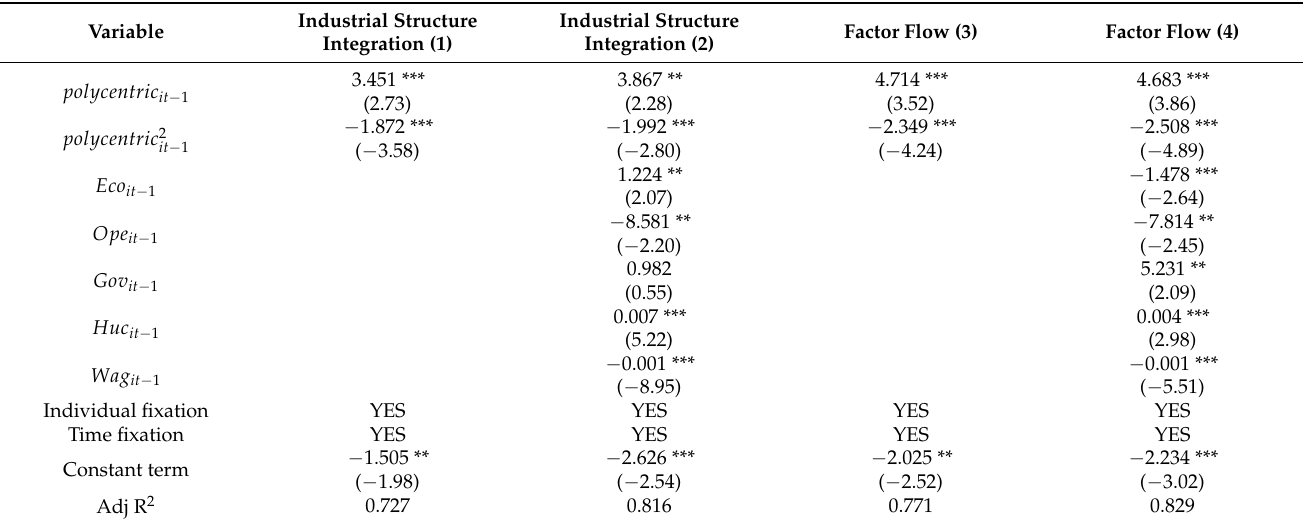
Table 6. Mechanism test of polycentric structure affecting ULUE.